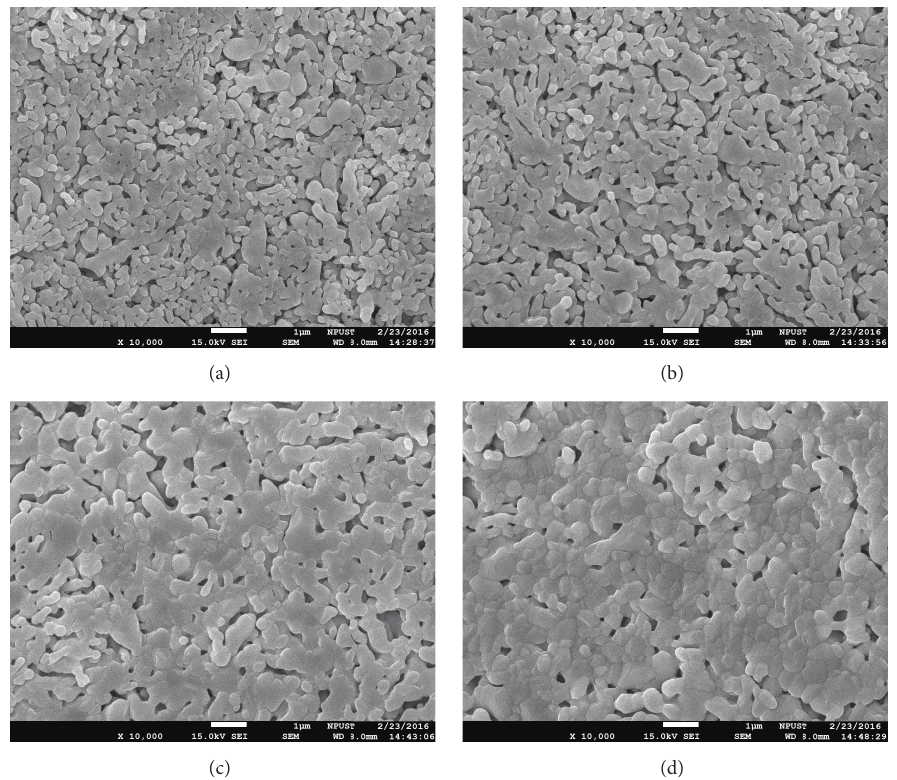
Figure 2: SEM of the microwave sintered ZrO 2 ceramics with addition of (a) 0, (b) 1, (c) 3, and (d) 5 wt% TiO 2 contents.